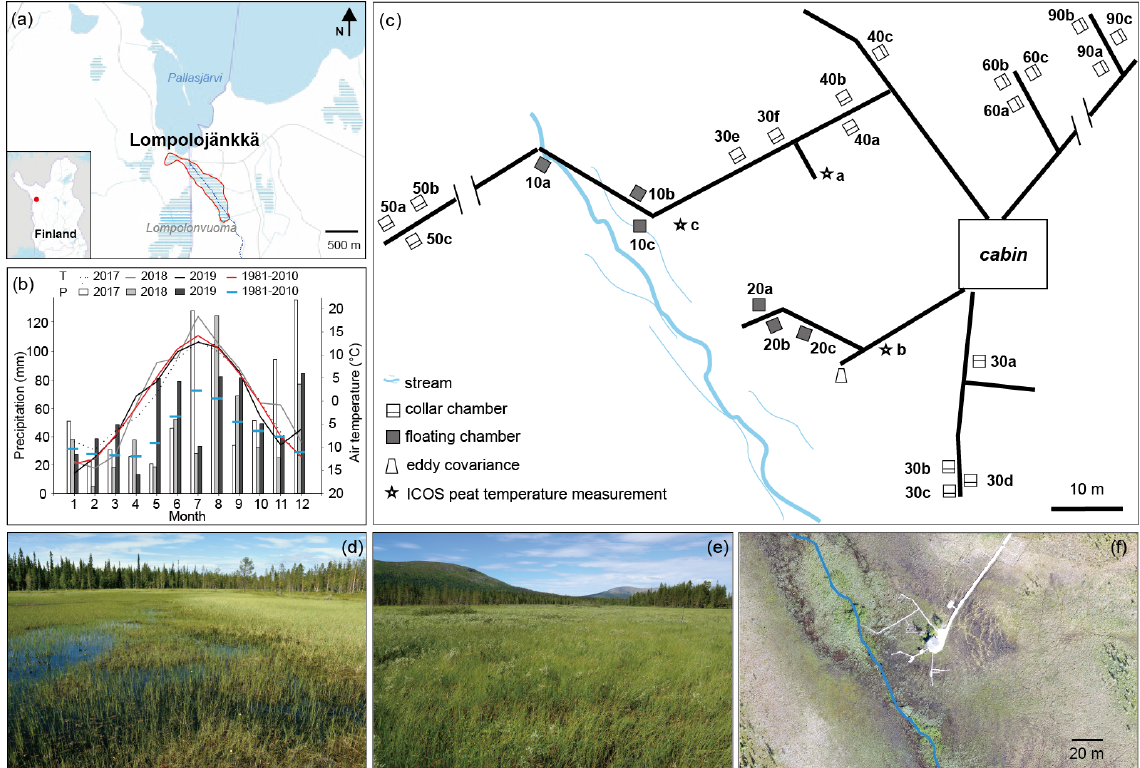
Figure 1. (a) Location of the Lompolojänkkä study site outlined in red, with the stream marked in blue. The base map was downloaded from the National Land Survey of Finland dataset under a Creative Commons Attribution 4.0 open-source licence. (b) Monthly air temperature ( T ) and precipitation ( P ) during the 2017–2019 period, and the long-term mean T and P values (1981–2010; Kittilä Pokka meteorological station https://en.ilmatieteenlaitos.fi/statistics-from-1961-onwards, last access: 1 July 2020). The data for the 2017–2019 period were obtained from the nearest meteorological stations: Lompolonvuoma (for temperature) and Kenttärova (for precipitation) (https://en.ilmatieteenlaitos. fi/download-observations-questions, last access: 1 July 2020). (c) Schematic illustration of the field measurement set-up. Note that some parts may not be scaled accurately. (d, e) Photos of the study site. (f) Drone image of the field measurement area on 20 August 2018 with the stream marked in blue.